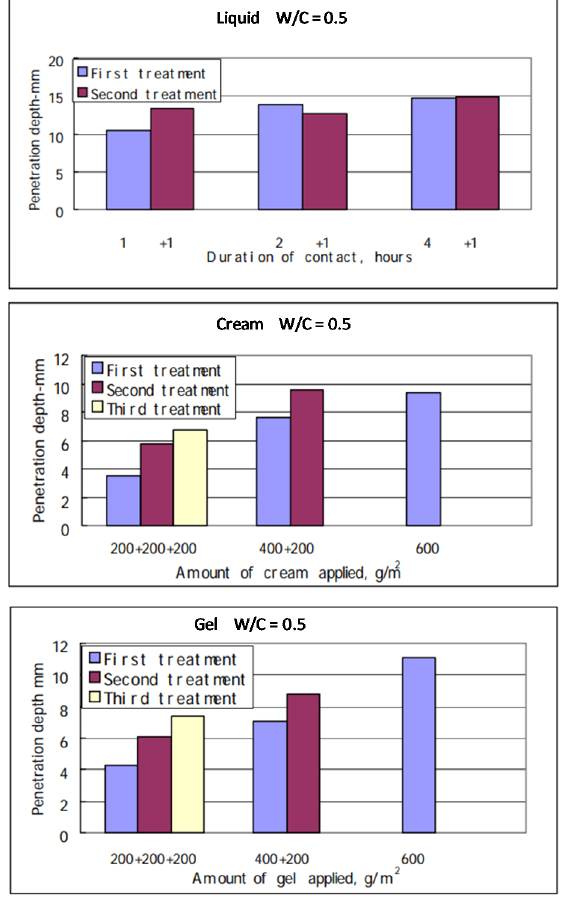
Figure 10. Penetration depth for liquid, cream, and gel silane treatment [36].